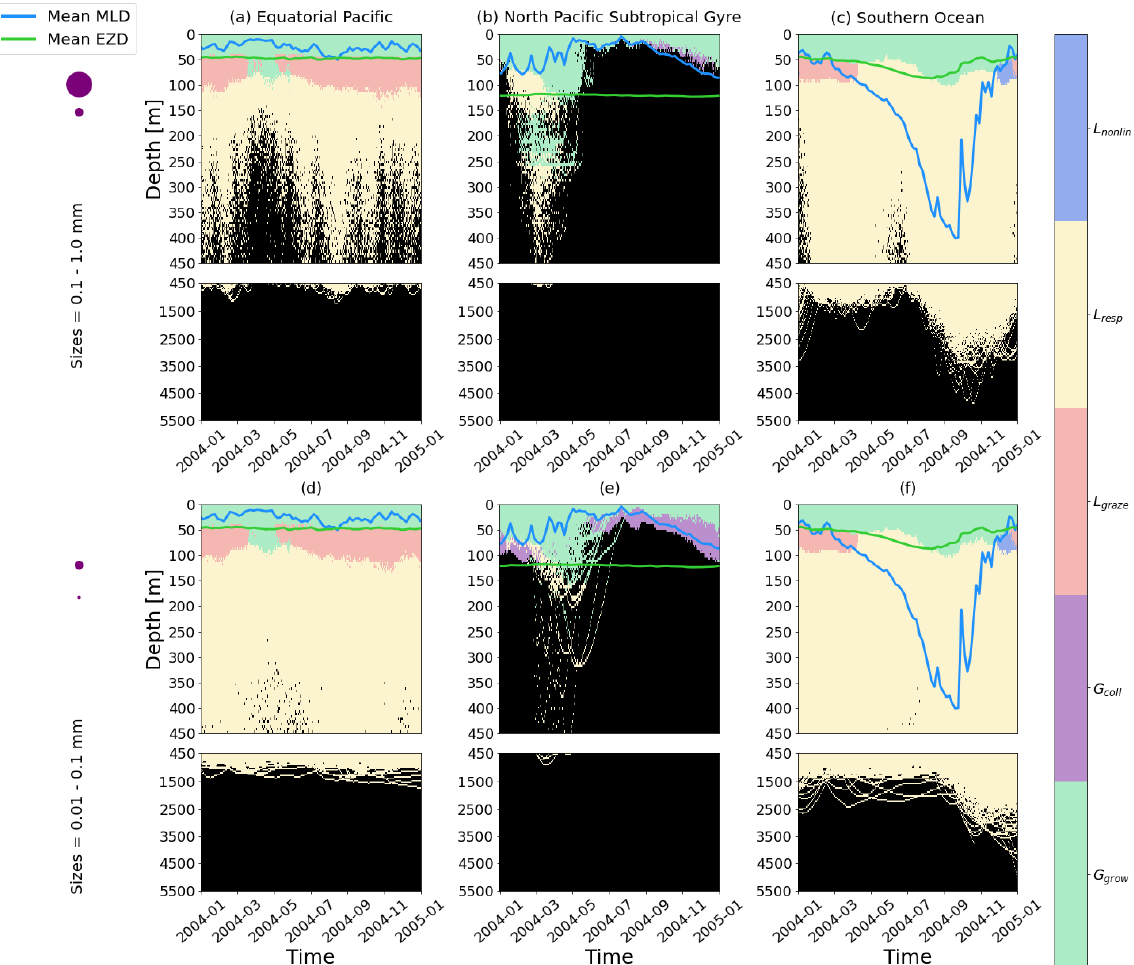
Figure 5. The dominant term out of the five terms that determine the gains and losses of biofilm dynamics on the plastic particles from Eq. (6), over the 1-year trajectories in Fig. 2. The three loss terms are nonlinear loss ( L nonlin ) in blue, respiration ( L resp ) in yellow and grazing from mesozooplankton ( L graze ) in orange. The two biofilm gain terms are via collisions with planktonic diatoms ( G coll ) in purple and growth ( G grow ; primary productivity) in green. The horizontally averaged mixed-layer depth (blue line) and euphotic-zone depth (green line) are also displayed. The same simulation duration, depth range, three regions and two size classes as in Fig. 2 are